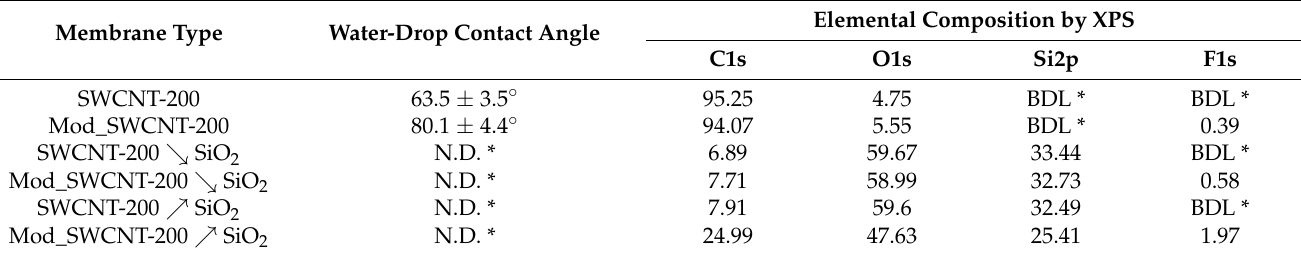
Table 5. Water contact angle and XPS results of unmodified and modified SWCNT membranes. Membrane Type Water-Drop Contact Angle